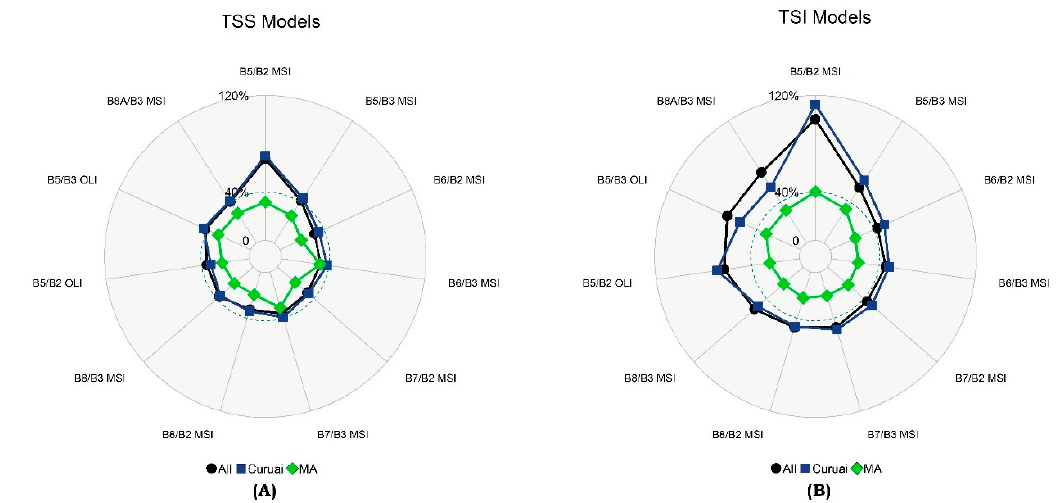
Figure 8. The MAPE values (%) obtained through a Monte Carlo simulation for R rs,sim_sat for both sensors using band-ratio models based on the Lake Dataset: ( A ) the band-ratio models for TSS and ( B ) the band-ratio models for TSI. The validation sample size for each lake: Curuai = 20 and Monte Alegre = 5. The R² and RMSE are in the Supplementary Files B. “All” at the bottom of the legend for TSS and TSI refers to the MAPE values for the All Dataset models (The values are in Table 3).